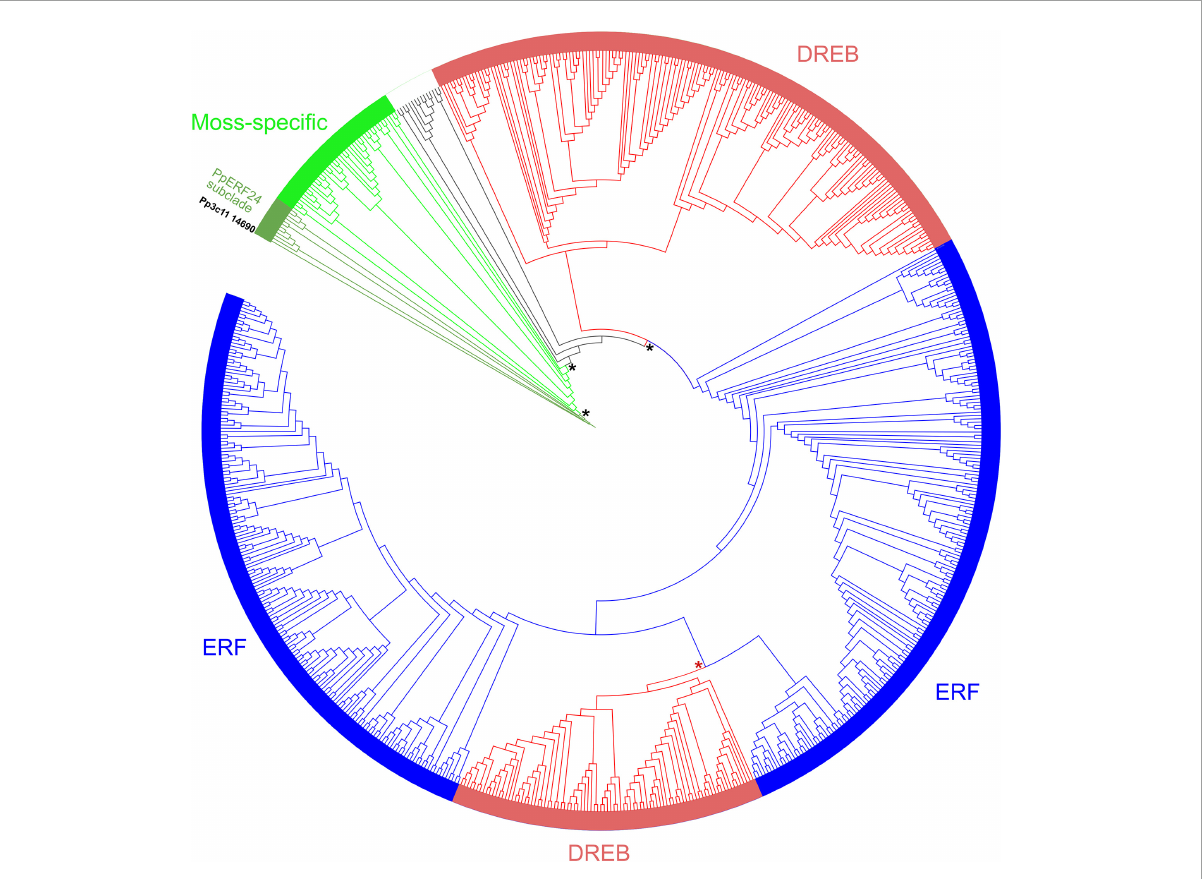
FIGURE1 Unrooted phylogenetic tree of AP2 domains of moss, liverwort, hornwort, and angiosperms. Unrooted maximum likelihood phylogenetic tree was visualized with iTOL. Subfamilies are indicated with different colors: ERFs (blue), DREBs (red), and moss-specific proteins (green). The moss-specific clade, the PpERF24 subclade, ERFs, and DREBs clades are supported by bootstrap values ≥ 95 (black asterisk). A bootstrap of 92 separate ERFs and DREBs (red asterisk). Pp3c11_14690 (PpERF24) is highlighted in black. See Supplementary Table 4 for complete information.